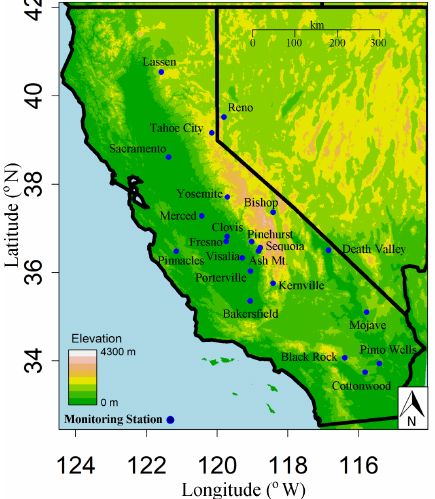
Figure 1. Study area and air monitoring locations.